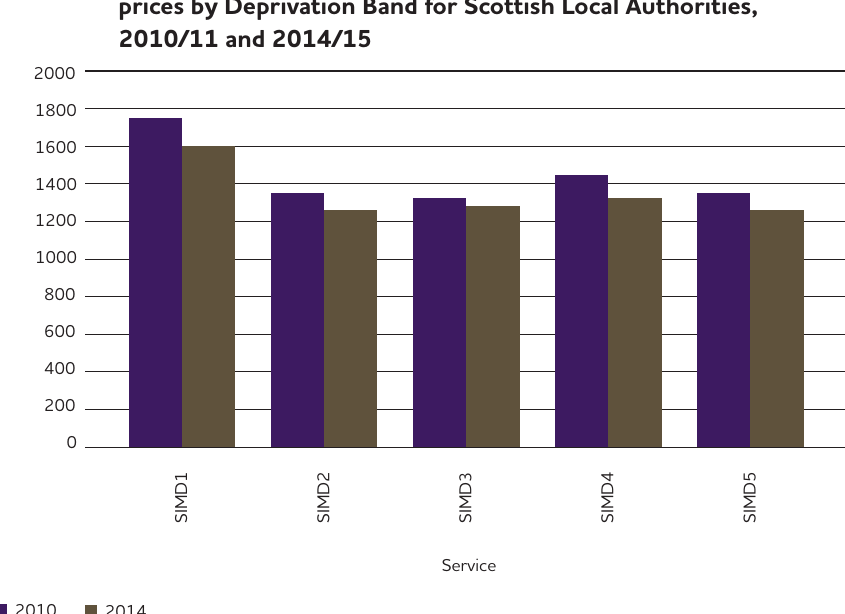
Figure 11: Expenditure per capita on non-education services at 2014 prices by Deprivation Band for Scottish Local Authorities, 2010/11 and